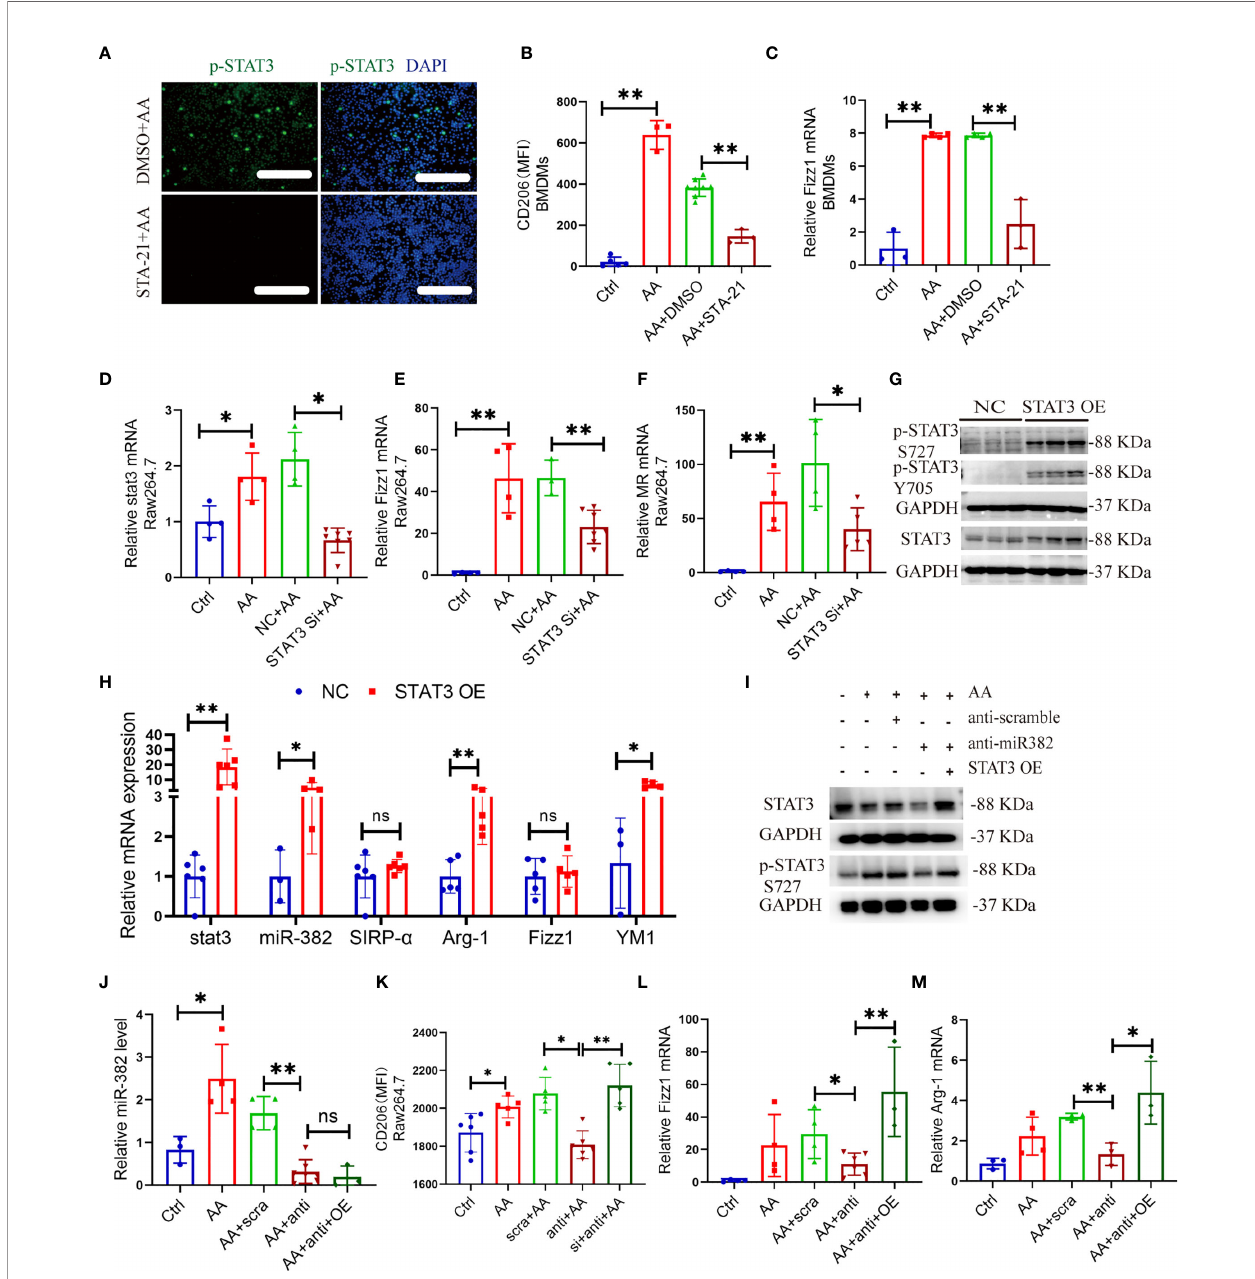
FIGURE 9 | STAT3 regulates activation of macrophage in vitro , which is partly mediated by miR-382. (A) Images of immuno fl uorescence for p-STAT3 in DMSO+AA and STA-21+AA groups in Raw264.7 cells. Scale bars, 100 m m. (B) MFI of CD206+ macrophages in BMDMs from control, AA, DMSO+AA, and STA-21+AA groups. (C) Relative of mRNA expression of Fizz1 in BMDMs from control, AA, DMSO+AA, and STA-21+AA groups. (D – F) Relative of mRNA expression of stat3, Fizz1, and MR in Raw264.7 cells from control, AA, NC+AA, and STAT3 siRNA+ AA groups. (G) Representative immunoblot for p-STAT3 S727, p-STAT3 Y705, and STAT3 in Raw264.7 after overexpression of STAT3. GAPDH served as standard. (H) Relative of transcripts for stat3, miR-382, SIRP- a , Arg-1, Fizz1, and Ym-1 in Raw264.7 cells after STAT3 OE plasmid transfection, NC as control. (I) Images of Western blot for p-STAT3 and STAT3 in Raw264.7 cells from ctrl, AA, anti- scramble+ AA, anti-miR-382+ AA, and anti-miR-382+ STAT3 OE+ AA groups. GAPDH served as standard. (J) Abundance of miR-382 in ctrl, AA, anti-scramble+ AA, anti-miR-382+ AA, and anti-miR-382+ STAT3 OE+ AA groups. U6 served as standard. (K) MFI of CD206+ macrophages in ctrl, AA, anti-scramble+ AA, anti- miR-382+ AA, and anti-miR-382+ STAT3 OE+ AA groups. (L, M) Relative mRNA of Fizz1 and Arg-1 in ctrl, AA, anti-scramble+ AA, anti-miR-382+ AA, and anti-miR- 382+ STAT3 OE+ AA groups. 18s served as standard. *P < 0.05; **P < 0.01;